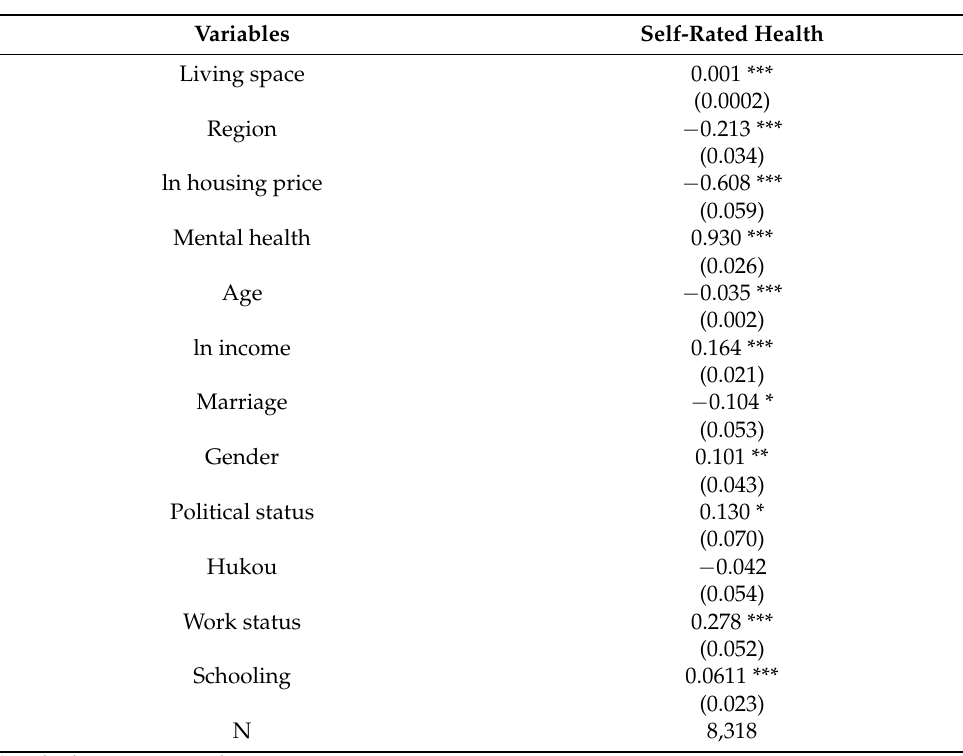
Table A1. Results for stepwise ordered logistic regression of self-rated health.